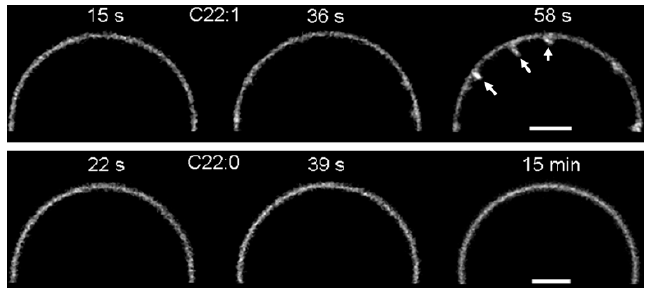
Figure 6. Induction of tubular membrane invaginations by fluorescently labeled STxB on Gb3- containing GUVs. Note that less than 1 min after addition of STxB, tubular membrane invaginations (arrows) were observed on GUVs that contained a C22 Gb3 species with a single unsaturated acyl chain (top panel, C22:1)). In contrast, no tubules were observed on GUVs that contained a C22 Gb3 species with fully saturated acyl chain (bottom panel, C22:0), even after dozens of minutes of incubation with STxB. Bars = 5 µm. Reproduced with permission from Ref. [14] .